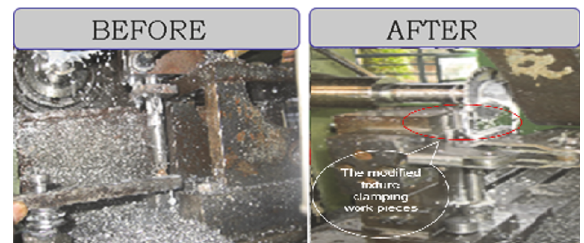
Figure 7: Fastening fixture before and after VSM implementation.